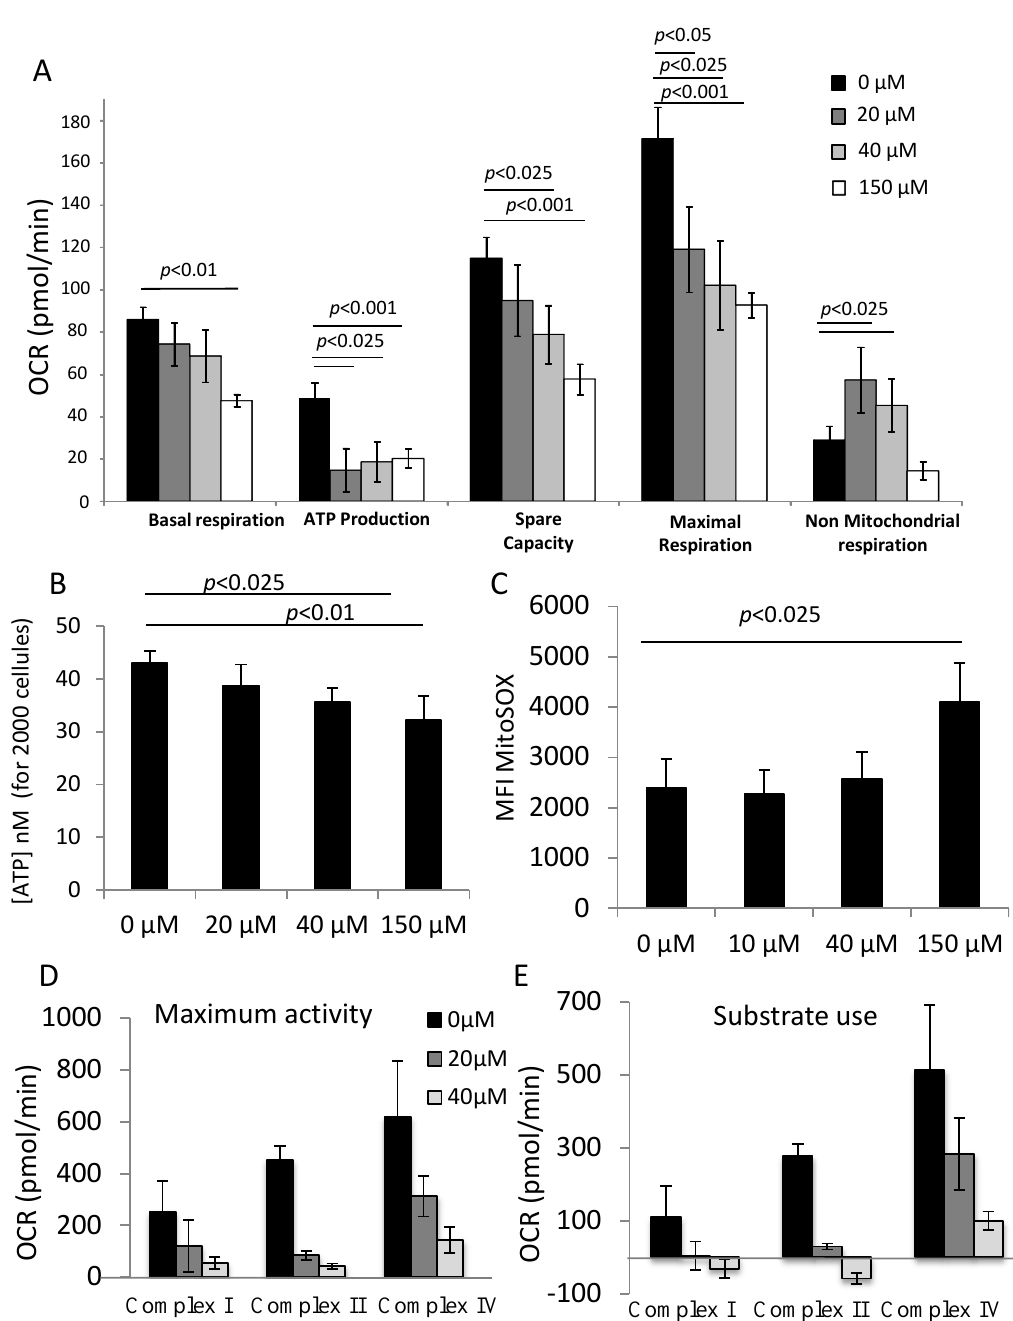
Figure 4. α TOA attenuates OXPHOS in CB CD34 + cells. ( A ) α TOA attenuates oxygen consumption rate in CB CD34 + cells, as well as the spare capacity and maximal capacity of OXPHOS after 24 h of culture. Seahorse indirect estimation of ATP production suggests an ATP decrease ( n = 6), which is confirmed by direct luminometry measurement ( B ) ( n = 6). ( C ) Mitochondrial ROS production (MitoSox probes) increases only with 150 µ M of α TOA after 24 h of culture ( n = 6). ( D ) Individual activity and substrate use ( E ) of the respiratory chain complexes I, II and IV after 24 h of culture with 20 µ M or 40 µ M α TOA; a decrease in activity for all complexes after α TOA application was noted ( n = 2). Data are presented as means +/ − SD. OCR = Oxygen Consumption Rate; ATP = Adenosin TriPhosphate; MFI = Mean Fluorescence Intensity.